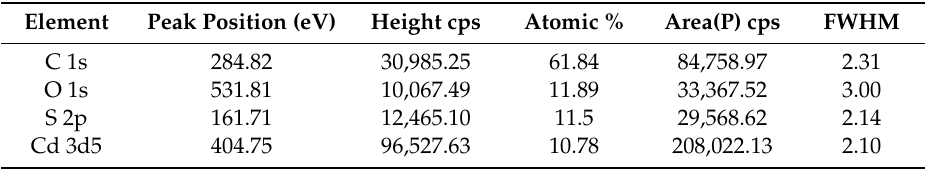
Table 1. Elemental data obtained from the XPS survey of the cadmium-sulfide-decorated cellulose nanofibrils (CNFs@CdS) adsorbent.